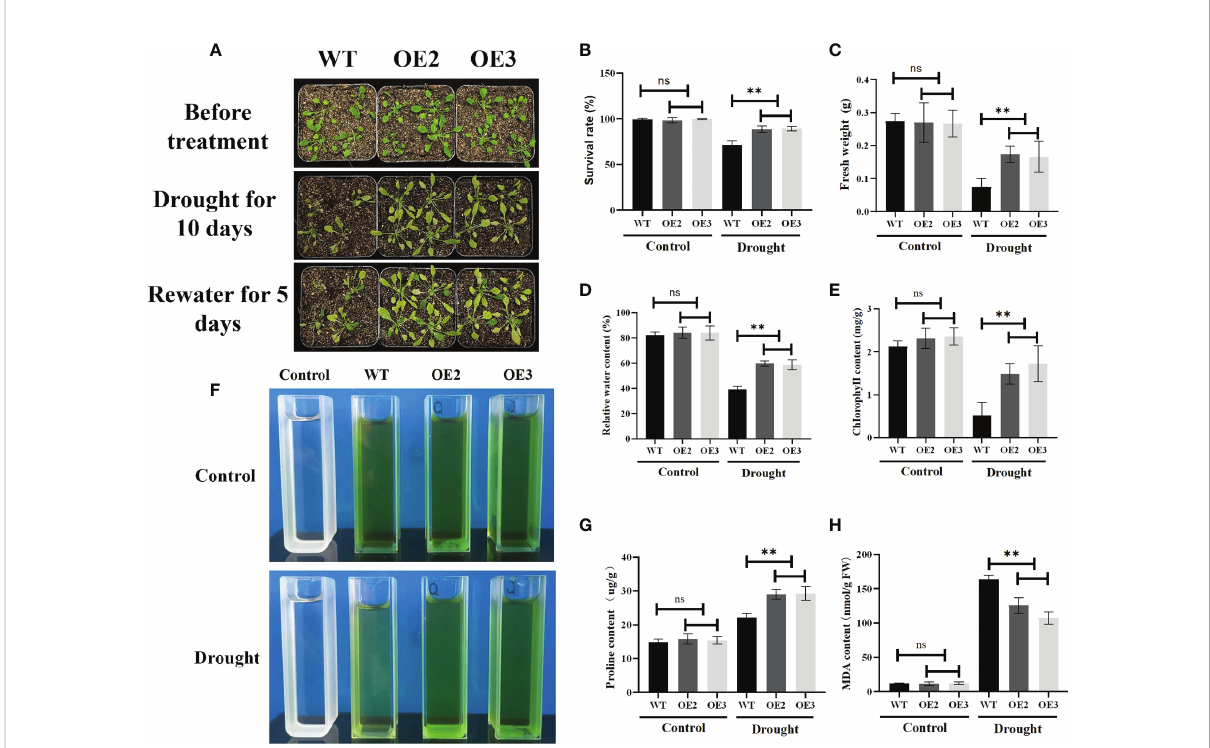
FIGURE 9 Phenotypes of the ZmLBD2-overexpressing transgenic plants and wild-type controls in A. thaliana under drought conditions. (A) Drought treatment using 30 days plants. The wild-type controls and transgenic plants were grown in pots for 30 days and then subjected to drought treatment for 10 days. The plants were watered again 5 days after the treatment. Survival rate (B) , fresh weight (C) , relative water content (D) , chlorophyll content (E, F) , proline content (G) , and MDA content (H) in transgenic Arabidopsis plants and wild-type controls under normal conditions and drought stress. Data were expressed as the mean of triplicate values, and error represented the SD. The ** represents p < 0.01, respectively. Non-signi fi cant